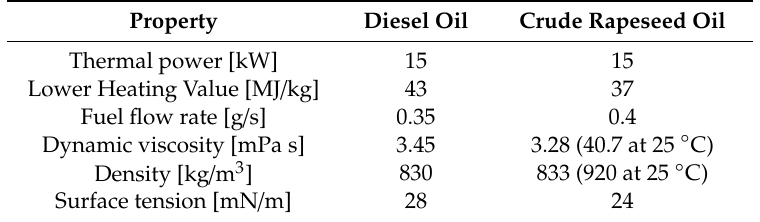
Table 3. Fuel properties of diesel oil at 25 ◦ C and crude rapeseed oil at 150 ◦ C [31,41]. Property Diesel Oil Crude Rapeseed Oil Thermal power [kW]